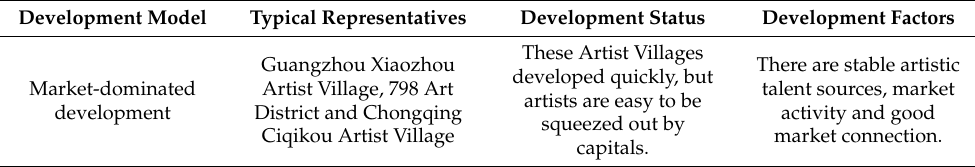
Table 3. Development status and development factors of different modes of Artist